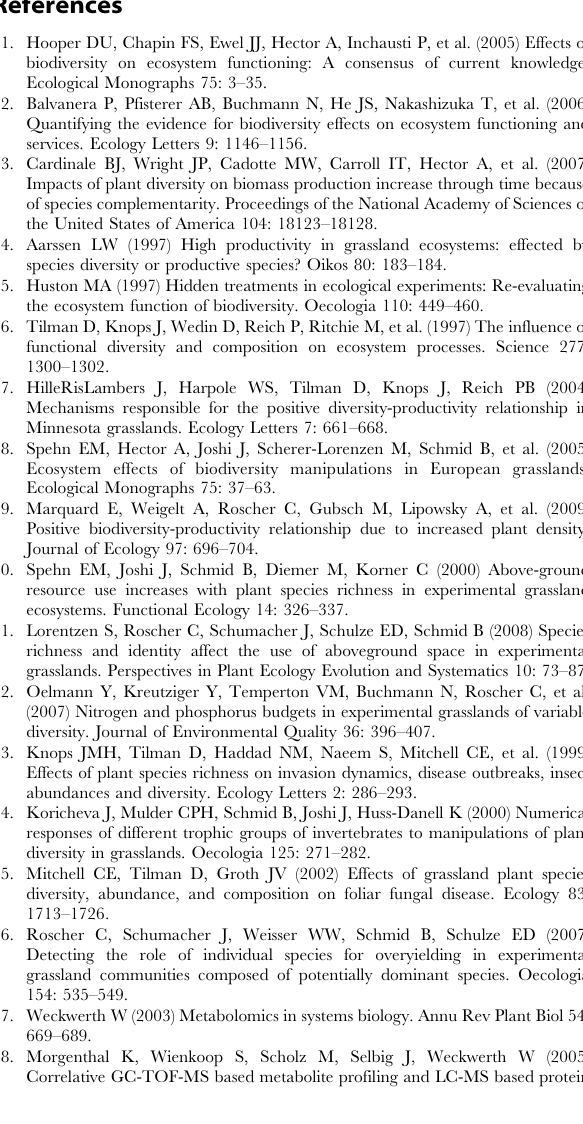
Figure S2 Biplots of standardized principal components analysis (PCA; first vs. second axis) based on LC-FT-MS metabolite data analysed for (a) Medicago x varia, and (b) Lotus corniculatus. Labels indicate the sown number of species in the assemblages where species were sampled (abbreviations see also legend of Fig. S1). Symbols indicate: white squares = assemblages where the studied legumes grew in combination with non-legumes; black squares =assemblages where the studied legumes grew in monoculture or in pure legume mixtures. Found at: doi:10.1371/journal.pone.0012569.s004 (0.03 MB